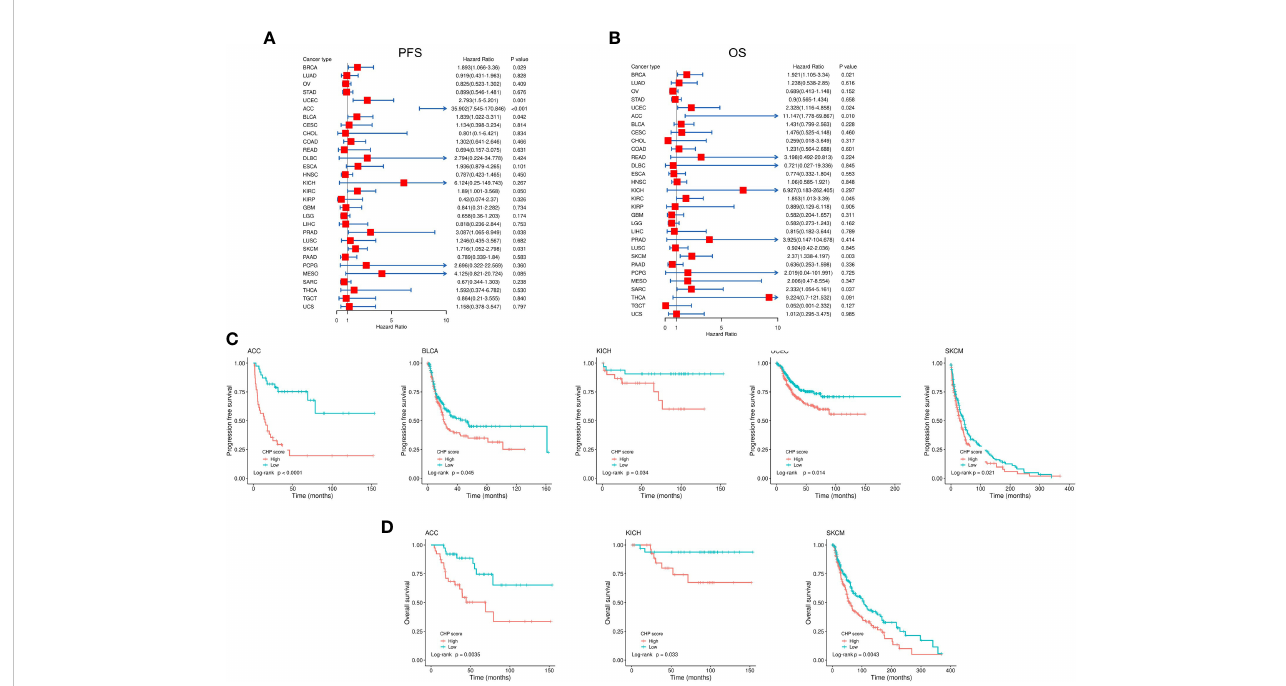
FIGURE 6 Evaluation of the correlation between CHP score and survival in 32 types of cancers. (A-B) Correlation between the CHP score and PFS (A) and OS (B) of 32 tumor types in the TCGA Database. (C) Kaplan-Meier curves of PFS in ACC, BLCA, KICH, UCEC, and SKCM. Patients were classi fi ed into CHP score high or low groups according to the median value of the CHP score. (D) Kaplan-Meier curves of OS in ACC, KICH, and SKCM, after patients were classi fi ed into CHP score high or low